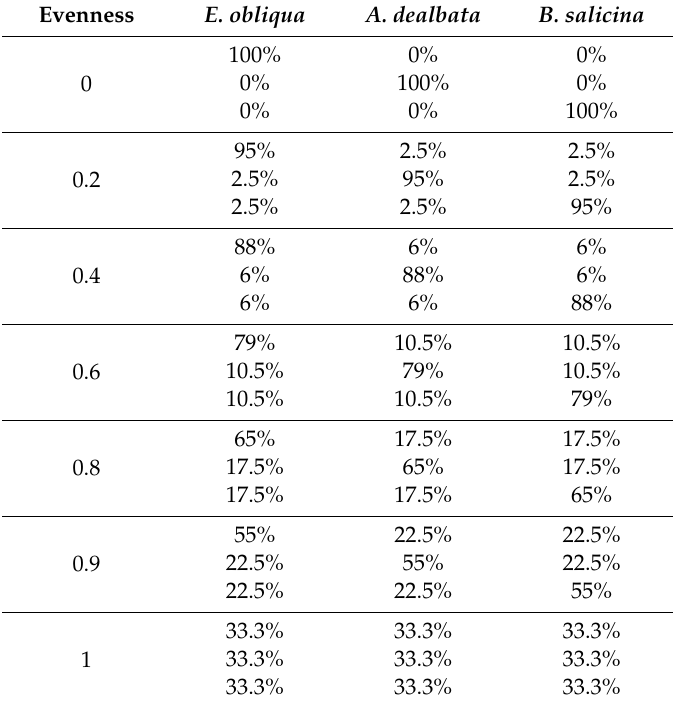
Table 1. Relative proportion of litter across the seven treatments (ranging from an even mixture of 1, to one dominated by a single species (0). The three species ( Eucalyptus obliqua L’H é r, Acacia dealbata Link, and Bedfordia salicina D.C.) are the most common found across the